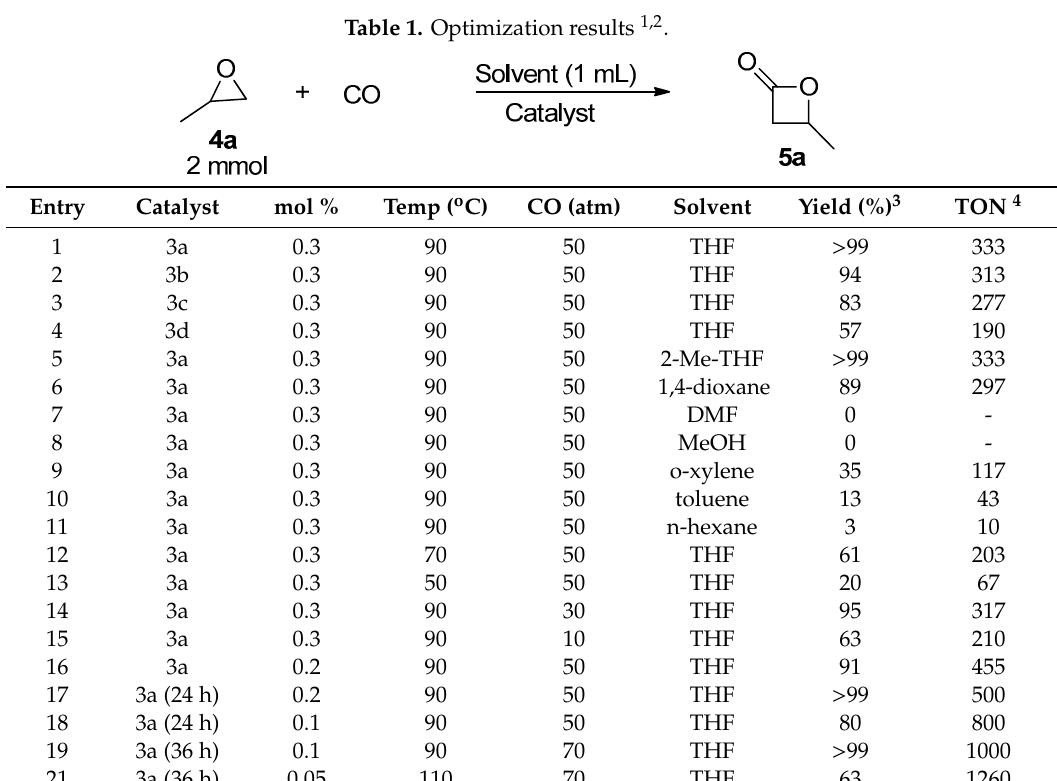
Table 1. Optimization results 1,2 .